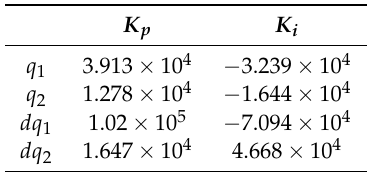
Table 2. Value of the gains of the PWM